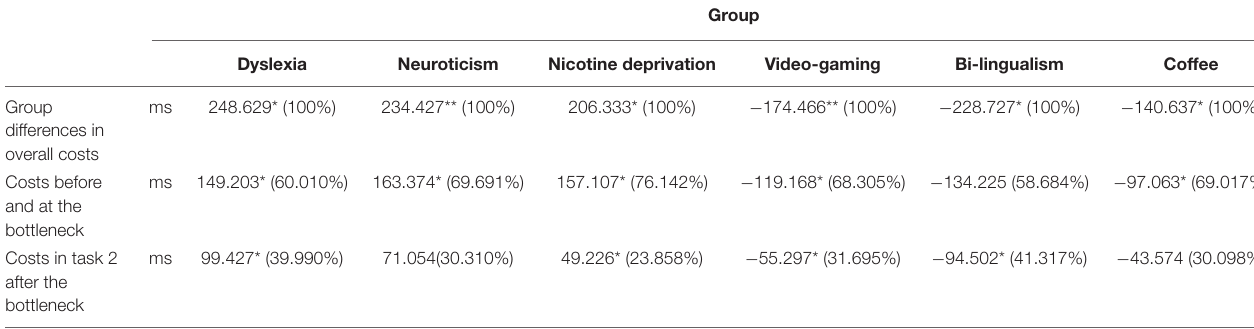
TABLE 4 | Detailed analysis of multitasking costs in Experiment Series